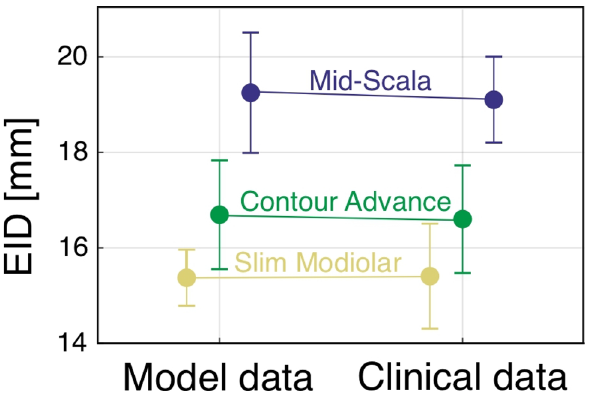
Figure 7. Comparison of model computations with previously published data on EID confirm the validity of the approximation based on corrosion casts, with nearly identical means and standard deviations. Clinical data for Contour Advance from Ref. 48 , Mid-Scala electrode from Ref. 49 and Slim Modiolar from Ref. 50 . Differences were not significant in all comparisons (two-sided t-test, p >